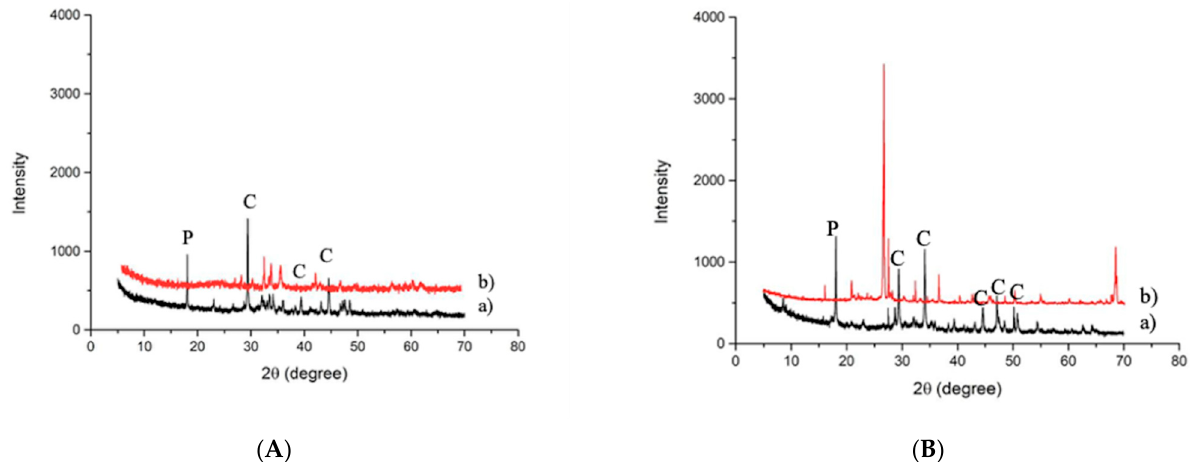
Figure 7. XRD patterns collected on ( A ) c-BOF slag and ( B ) De-S slag before (a) and after HCl test 1:20 (b) (C = calcite, P = portlandite).